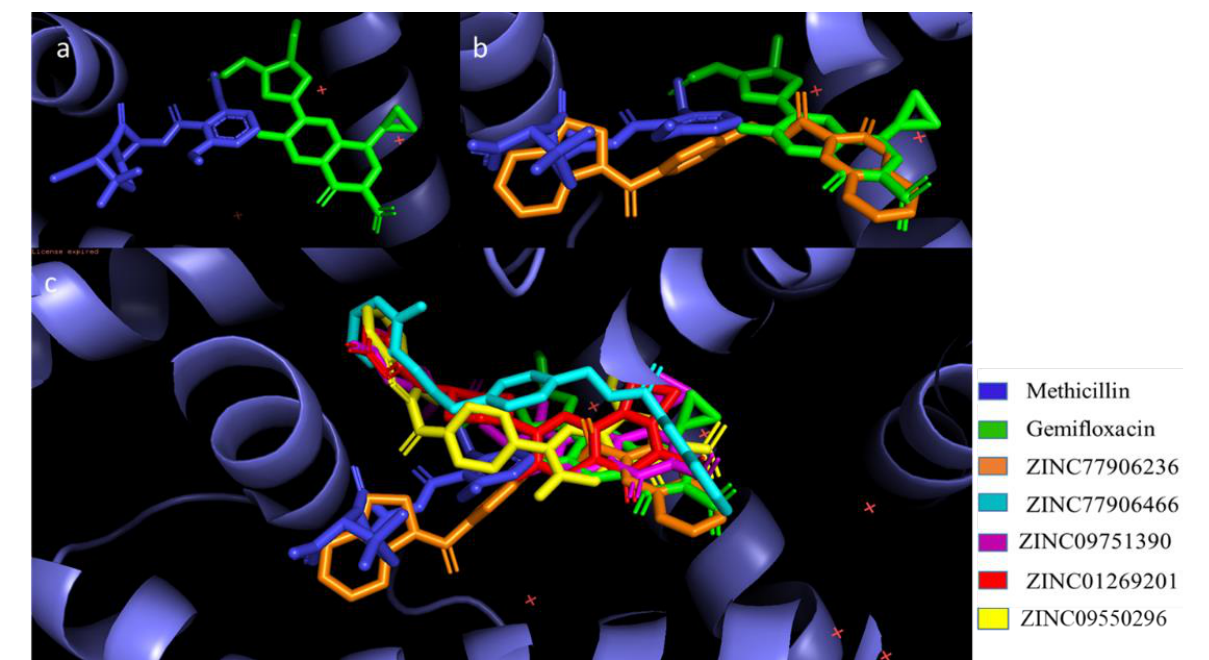
Figure 5. Diagram of the binding mode of methicillin and gemifloxacin ( a ). Superimposition of hit compound ZINC77906236 on methicillin and gemifloxacin in the active site of TcaR ( b ). The binding mode of methicillin, gemifloxacin, and hit compound ZINC77906236 ( c ). The binding mode of methicillin, gemifloxacin, and hit compounds (ZINC77906236, ZINC09550296, ZINC77906466, ZINC09751390, and ZINC01269201) in the active site of TcaR.